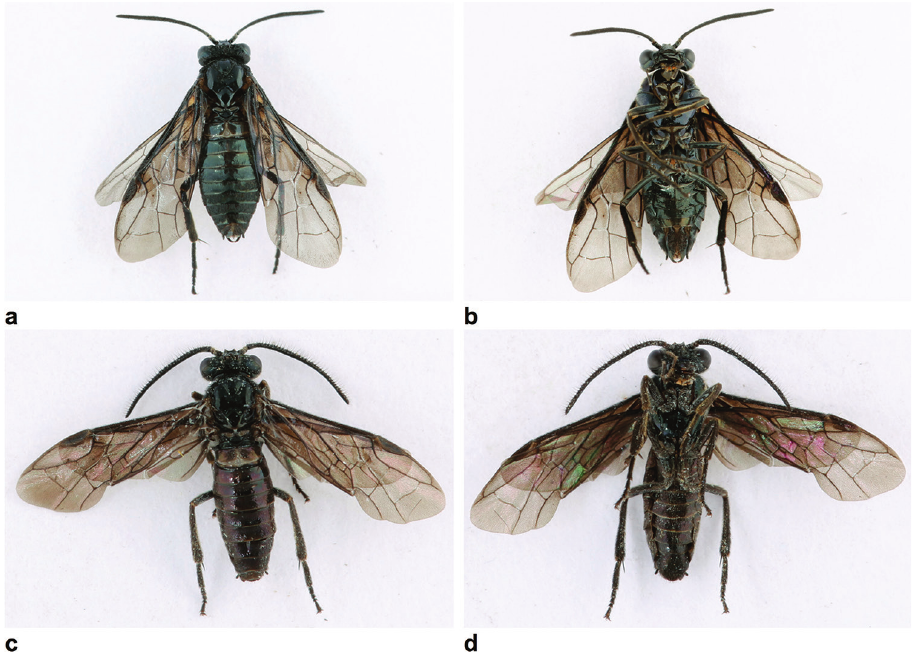
Figure 8. Scobina styx . a, b Female (P4239.F), body length 7.5 mm c, d male (P4238.L), body length 6.0 mm. a, c Dorsal views b, d ventral views.